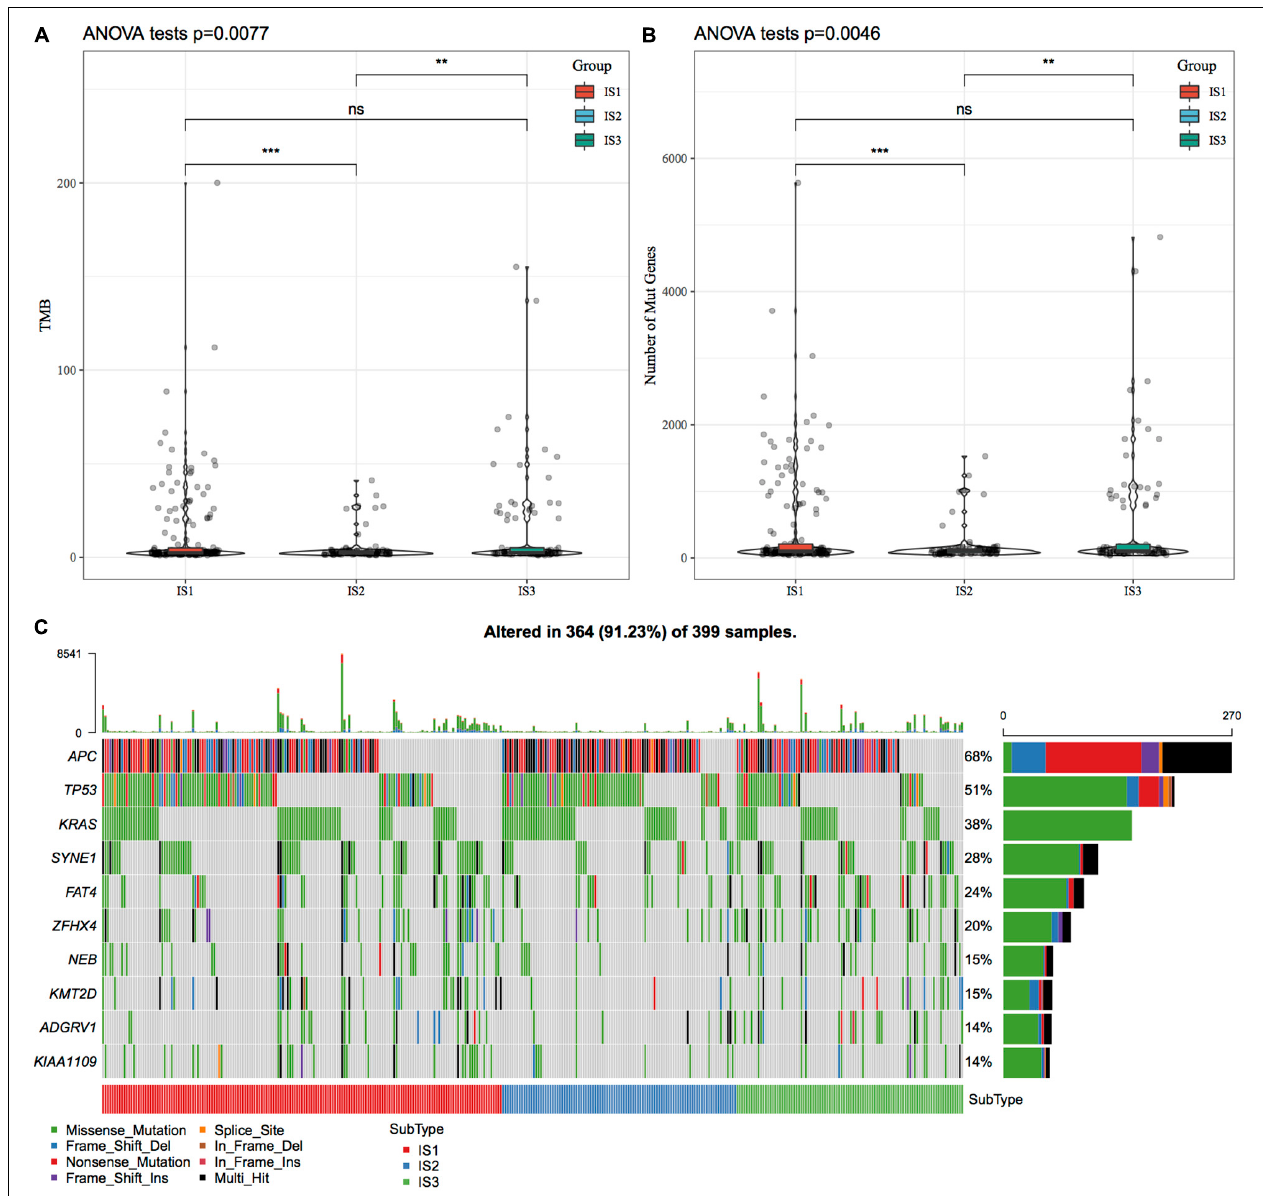
FIGURE 2 | The relationship between immunophenotyping and TMB and common gene mutations. (A) Differences in the distribution of the tumor mutation burden (TMB) in three molecular subtypes; (B) Differences in the distribution of the number of gene mutations in the three molecular subtype samples; Rank sum test was used to determine the P -value, * P < 0.05; ** P < 0.01; *** P < 0.001; (C) The mutation characteristics of significantly mutated genes with the mutation frequency of the top ten mutated genes in each subtype